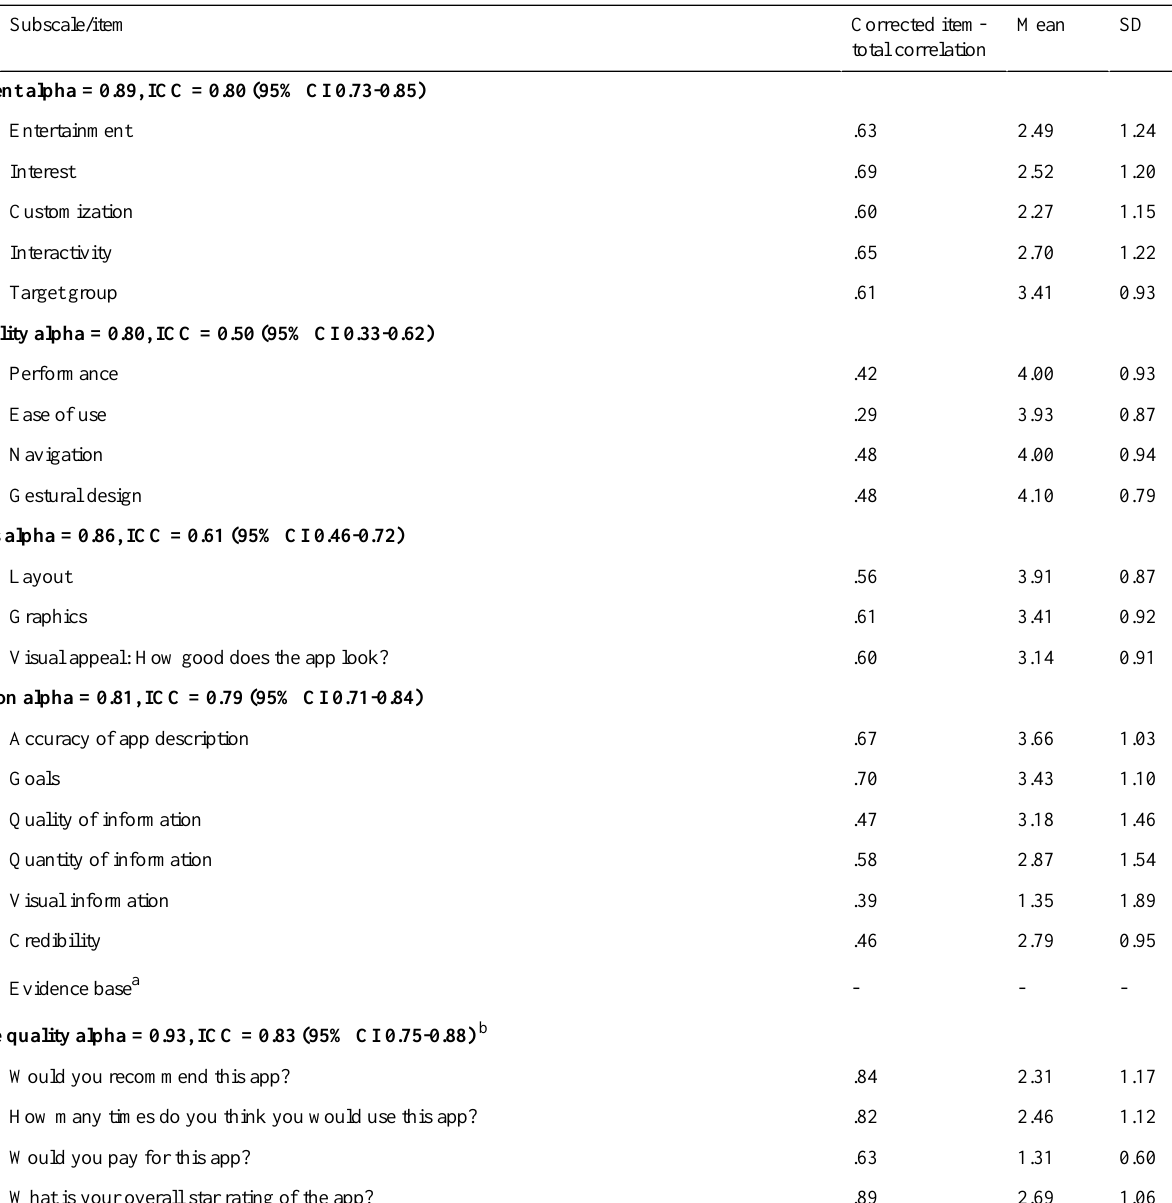
Table 2. Interrater reliability and internal consistency of the MARS items and subscale scores, and corrected item-total correlations and descriptive statistics of items, based on independent ratings of 50 mental health and well being